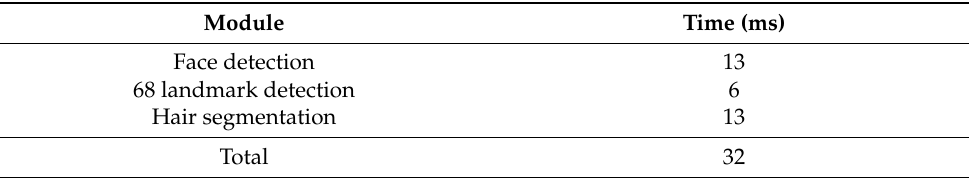
Table 4. Processing time of each module.